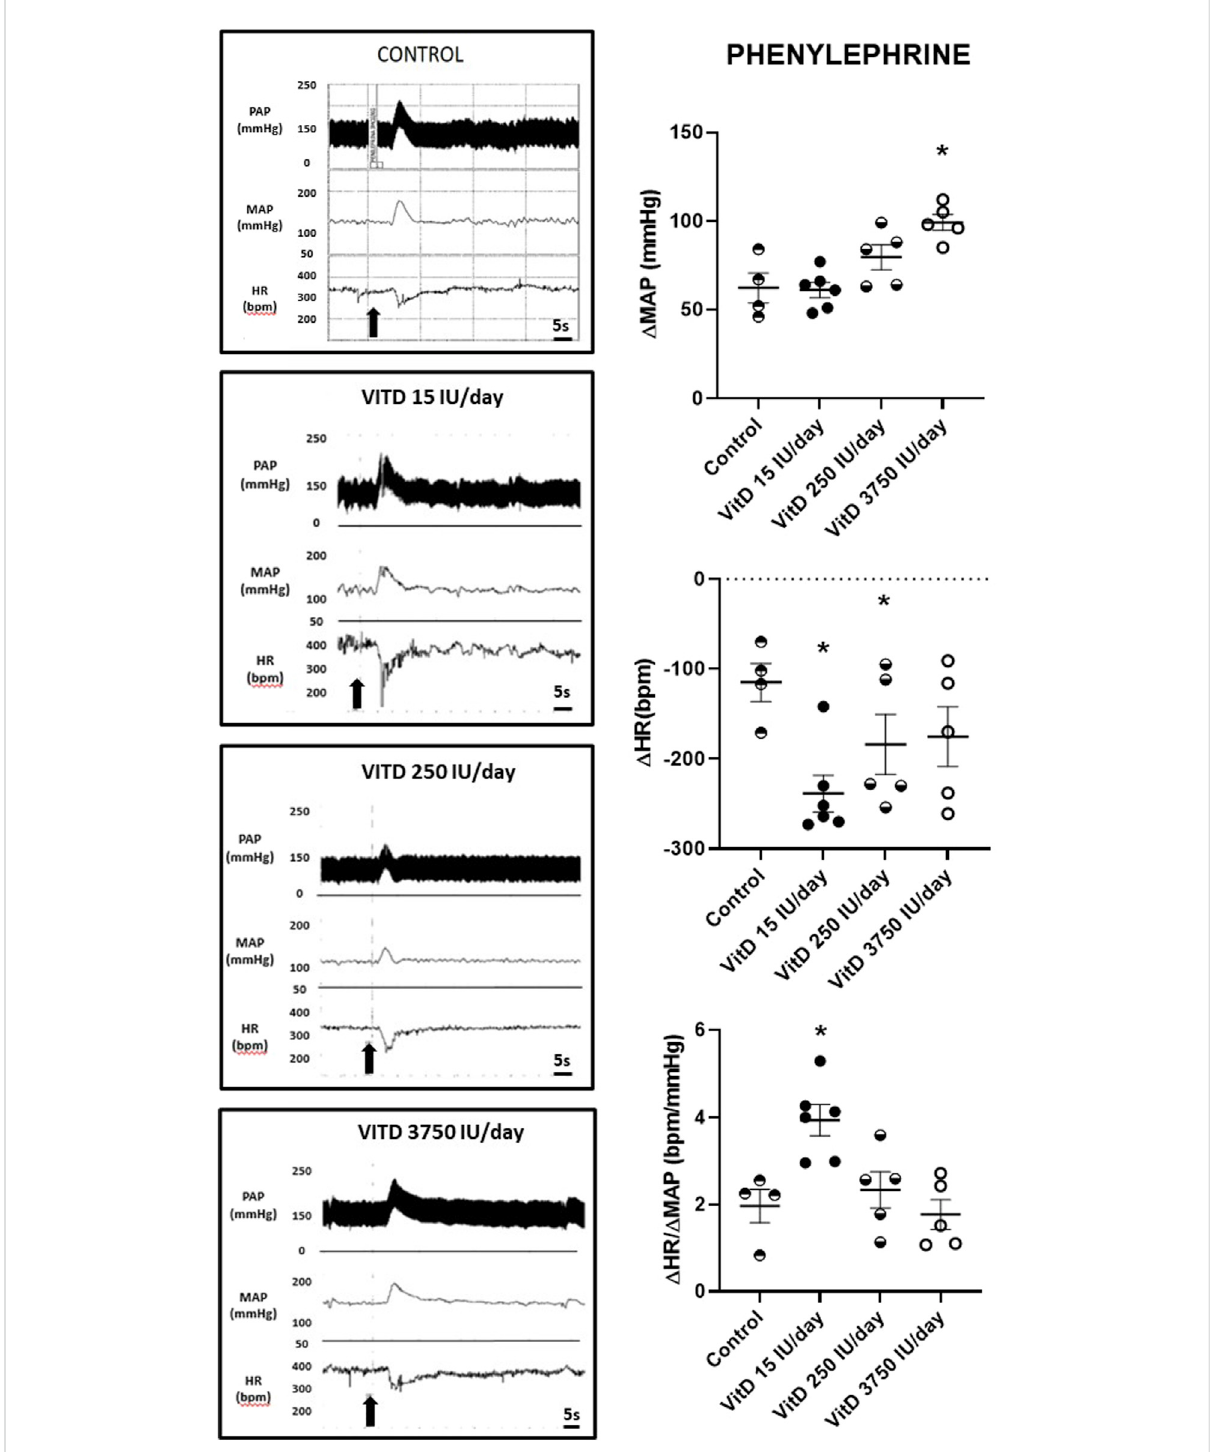
FIGURE 1 Left panels — Pulsatile arterial pressure (PAP), mean arterial pressure (MAP, mmHg), and heart rate (HR, bpm) tracings in Control, and Vitamin D 15, 250 and 3,750 IU/day treated-rats for 3 days in which phenylephrine (3 μ g/kg of b.w.) was administrated in bolus injection intravenously. Right panels – Change in mean arterial pressure ( Δ MAP, mmHg), heart rate ( Δ HR, bpm), and index of baroreceptor re fl ex ( Δ HR/ Δ MAP in module, bpm/ mmHg) evoked by a pressor dose of phenylephrine (3 μ g/kg of b.w.) in Control rats and submitted to supplementation with different doses of Vitamin D (VitD 15, 250, 3,750 IU/day) for 3 days. ( n = 4 – 6/group). One-way ANOVA followed by Tukey posttest. * p < 0.05 vs.